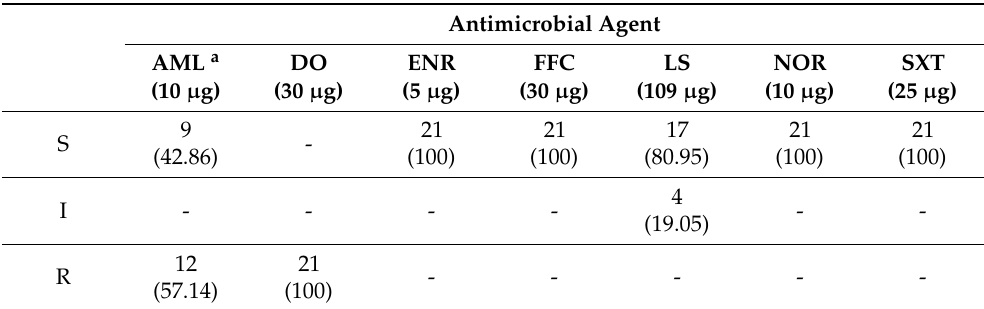
Table 2. Results of the antimicrobial susceptibility assay showing the number (%) of susceptible (S), intermediate (I) or resistant (R) strains to each tested antimicrobial agent.